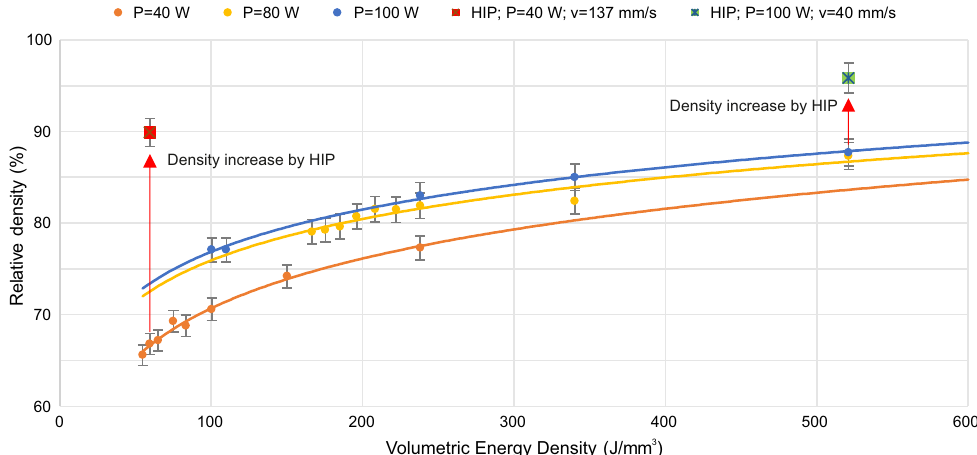
Figure 10. Relationship between energy density and subsequent HIP process and final density of builds from AW701